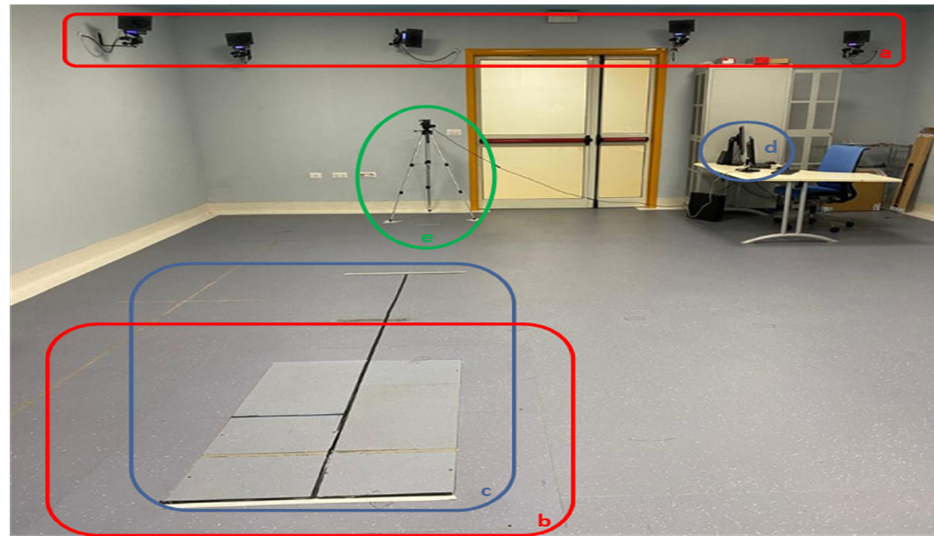
Figure 7. Testing layout.